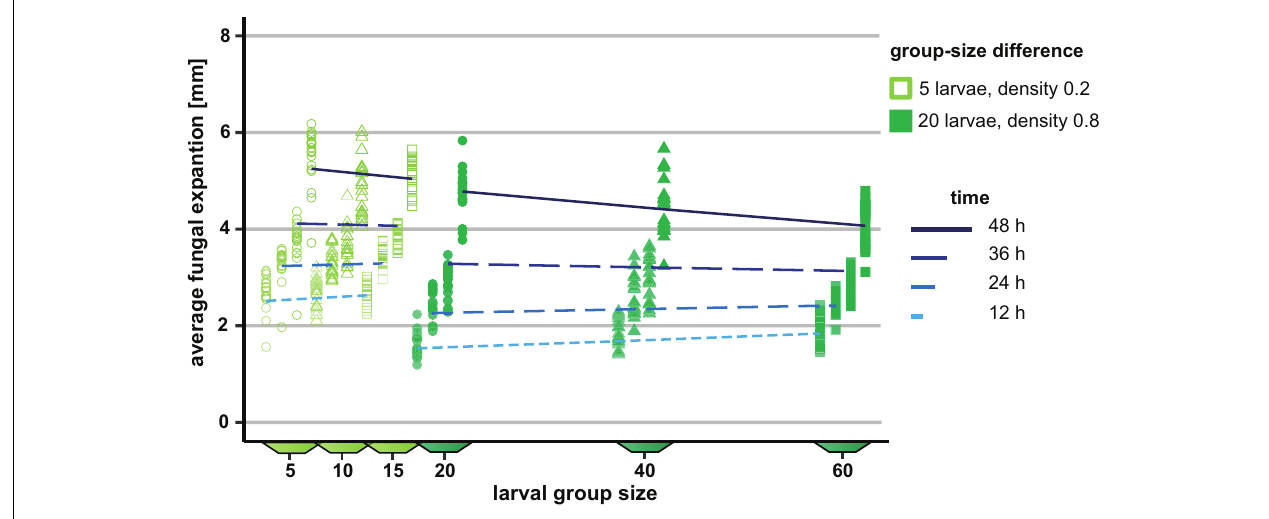
FIGURE 4 | Influence of variation in the group size of Drosophila melanogaster larvae on the spread of the insecticidal filamentous fungus Aspergillus nidulans . The influence of the three different group sizes on the expansion of the fungus was quantified at two different densities (0.2 and 0.8 larvae per millimeter of fungal growth front) at four different points in time. The differences in group size were 5 and 20 at the two density levels, respectively. For the sake of clarity, the data points within one group size per time are shown slightly shifted along the x -axis. Lines represent the adjusted model estimates for the four time points (generalized estimation equation).